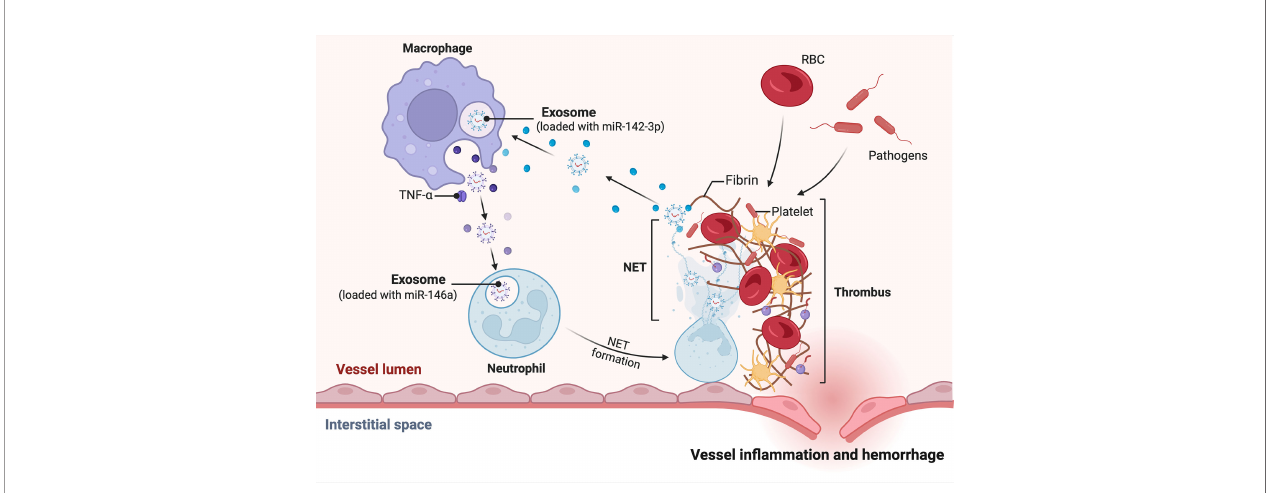
FIGURE 2 | miRNA-mediated regulation of in fl ammatory factors by NET released in neutrophils. Under the in fl uence of the vascular in fl ammatory environment, neutrophils, for example, mature macrophages release exosome-loaded miR-146, which stimulates neutrophil development and maturation to form NETs. The NETs supernatant contains miRNA, such as miR-142-3p. miR-142-3p targets macrophages to release more pro-in fl ammatory factors, which in turn accelerate the formation of a pro-in fl ammatory